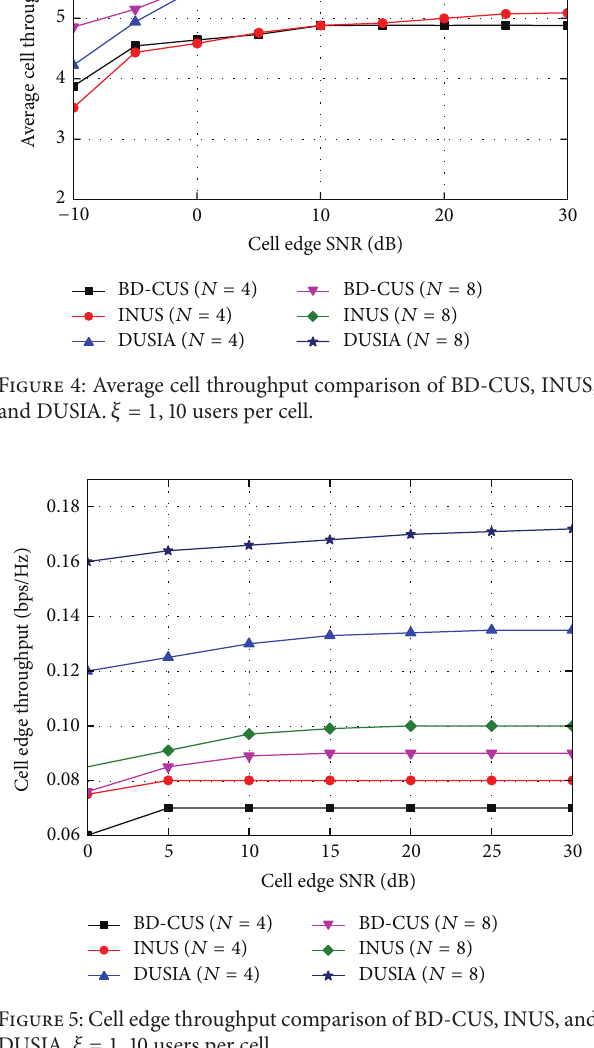
Figure 5: Cell edge throughput comparison of BD-CUS, INUS, and DUSIA. 𝜉 = 1 , 10 users per